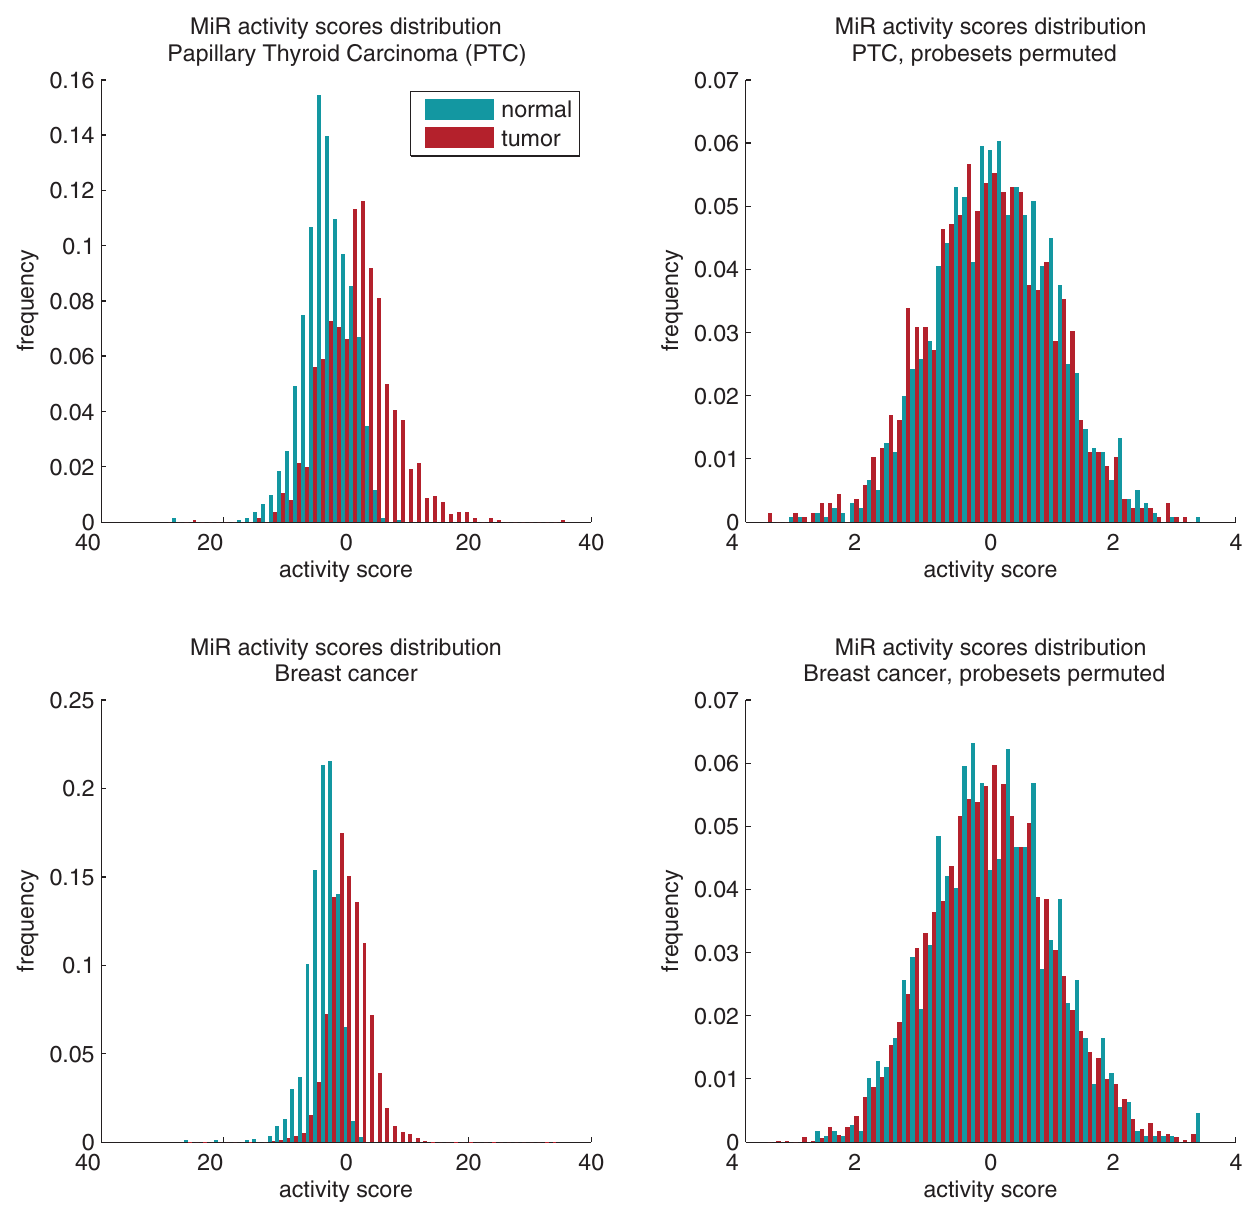
Figure 1. Distribution of the MiR activity scores calculated for tumor samples (red) and normal samples (cyan). (A) Histogram displaying the distribution of miR-seed activity scores computed for tumor (red) and normal samples (cyan) in the papillary thyroid carcinoma dataset. Activity of miRNAs is globally higher in tumor tissues relative to normal tissues. The KS test rejects the hypothesis of equality of the distributions of activity scores in tumor and in normal tissues, with a p-value P < 10 2 126 . Normality of the activity scores is rejected with P , 10 2 300 . (B) To show that the deviation between scores computed for normal and tumor tissues is not due to our method of calculating the activity scores, we computed these scores from a random permutation of the probe-sets from the PTC dataset. For both normal and tumor tissues, the activity scores follow approximately a normal distribution, as expected for a t-statistic. There is no observable deviation between tumor and normal tissues, and the KS test does not reject equality of the two distributions. (C) Histogram displaying the distribution of miR-seed activity scores computed for tumor (red) and normal samples (cyan) in breast cancer dataset. MiRNA activity is significantly higher in tumor tissues relative to normal tissues. The KS test rejects the hypothesis of equality of the distributions of activity scores in tumor and in normal tissues, with a p-value P , 10 2 298 . (D) Histogram displaying the distribution of miR-seed activity scores for a random permutation of the probe-sets from the breast dataset.